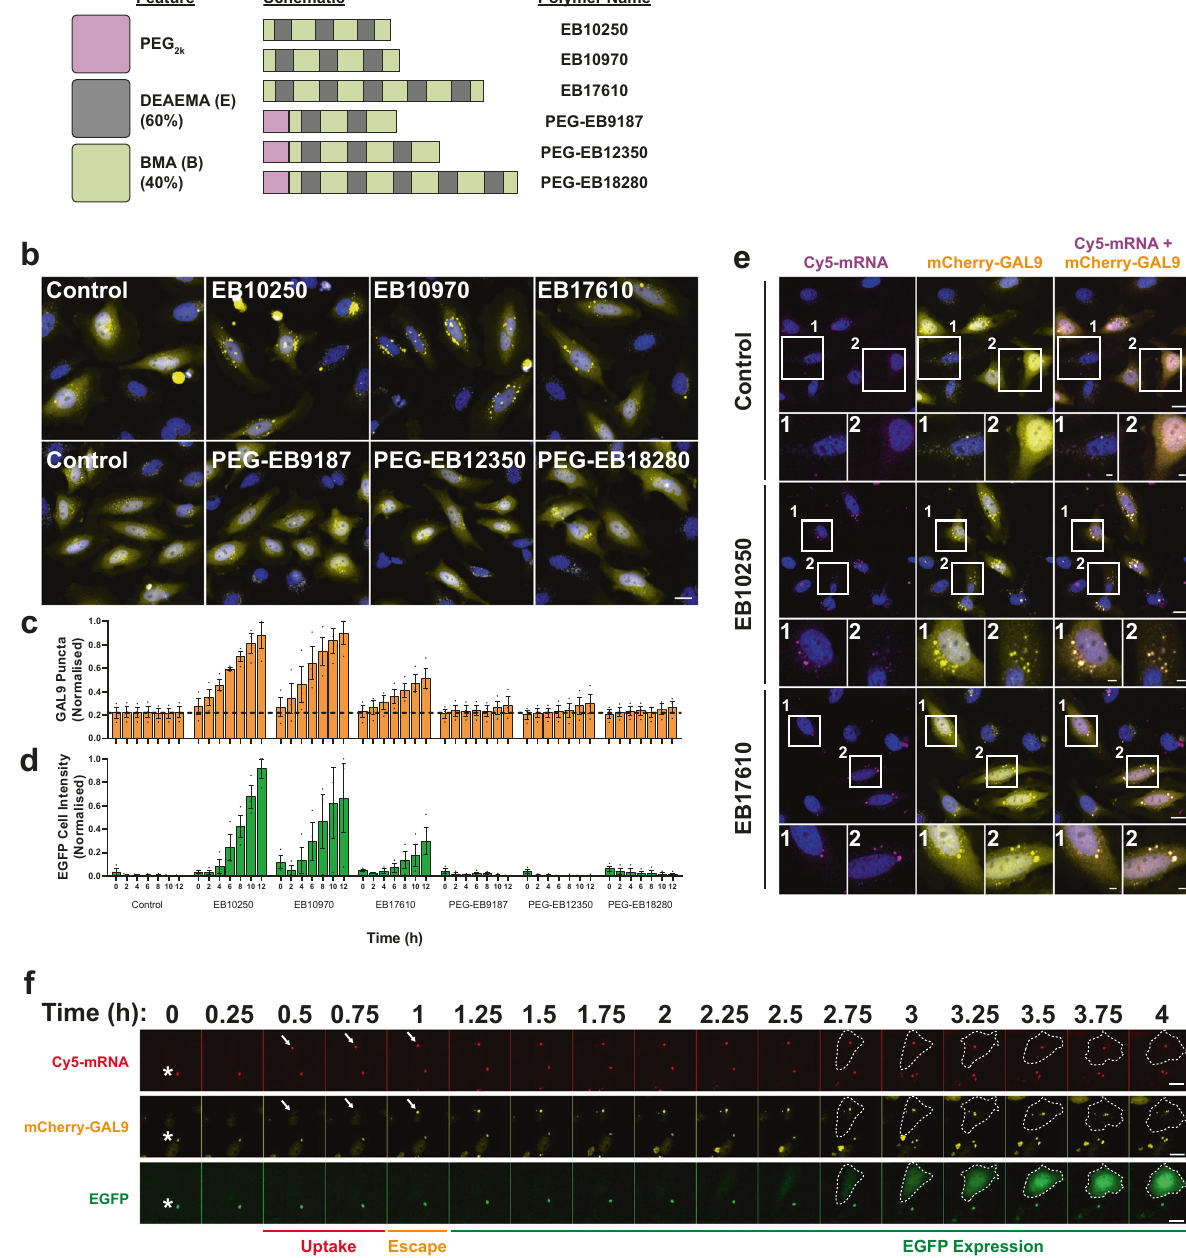
Fig. 4 mCherry-GAL9 responds to polymeric nanoparticles. a Overview of polymer names and compositions. Polymers are comprised of DEAEMA (60%) and BMA (40%) at variable lengths ± PEG 2k fi rst block. b Representative images of HeLa mCherry-GAL9 cells dosed with 1 µ g/ml of indicated polymers in serum-free media and imaged by live-cell microscopy, scale bar = 20 µ m. c Quantitation of cells treated as in ( b ) for mean mCherry-GAL9 structures or d mean EGFP expression both ± SEM from n = 3 independent experiments. e Representative images of HeLa mCherry-GAL9 cells treated with 1 µ g/ml of EB10250, EB17610 or PBS control. Scale bar = 20 µ m, insets = 5 µ m. f Images of HeLa mCherry-GAL9 cells dosed with EB10250 polymer at 1 µ g/ml in serum-free media and imaged live. Arrows indicate a single Cy5-mRNA particle taken up by a HeLa cell and undergoing endosomal escape, scale bar = 20 µ m. Asterix indicates a non-speci fi c auto fl uorescent signal present in all